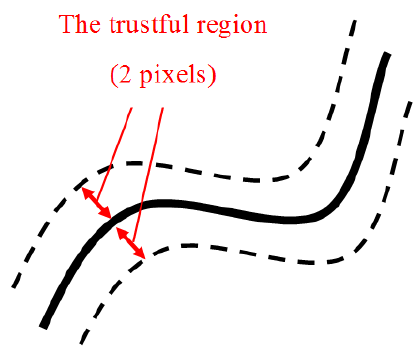
Figure 13. The conception of trustful region for lobe fissure